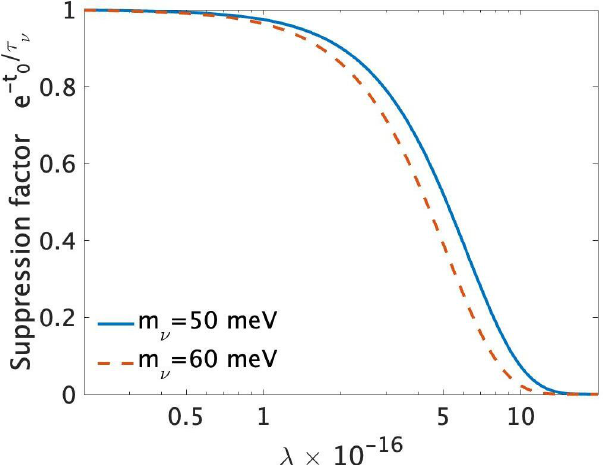
in the case of i